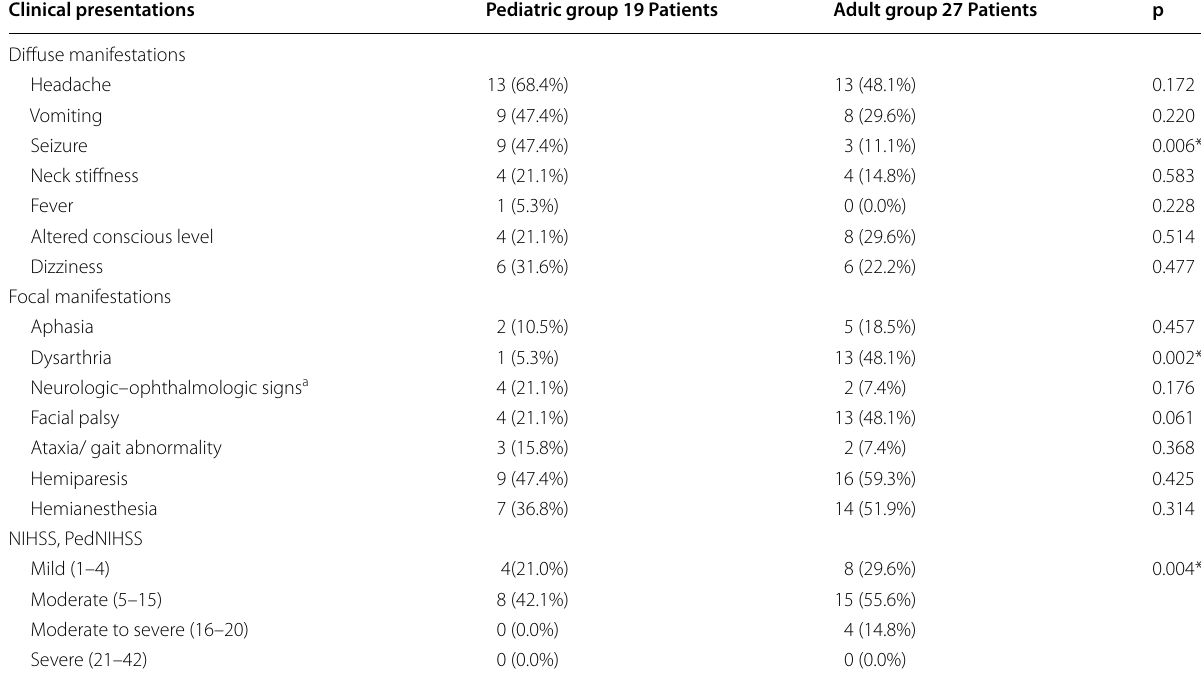
Table 4 Clinical presentations of hemorrhagic stroke in both group